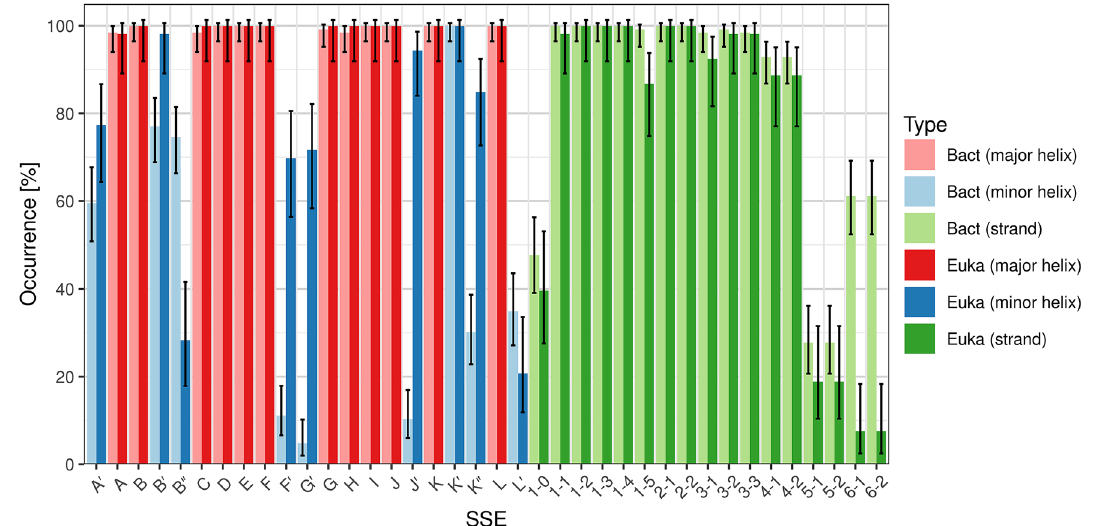
Figure 5. Comparison of SSE class occurrence in bacterial (Bact) and eukaryotic (Euka) CYP structures.